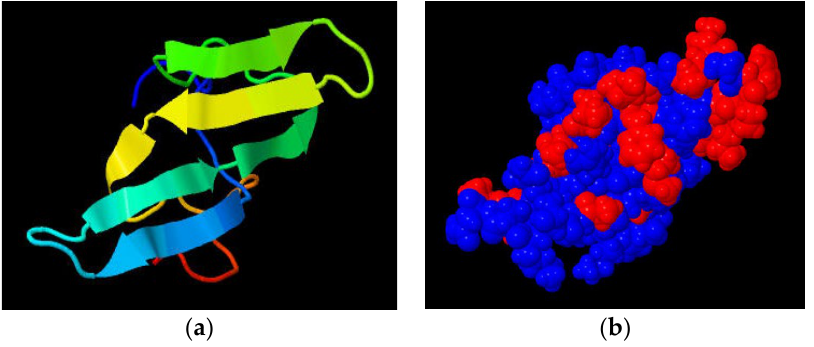
Figure 3. 3D structure ( a ) and surface properties ( b ) of soybean Bowman–Birk inhibitor as rendered by Jmol software using the coordinates available in the Brookhaven Protein Data Bank (http://www.rcsb.org/pdb) (accessed on 15 December 2021). Surface color mapping: blue for hydrophilic, red for hydrophobic regions.